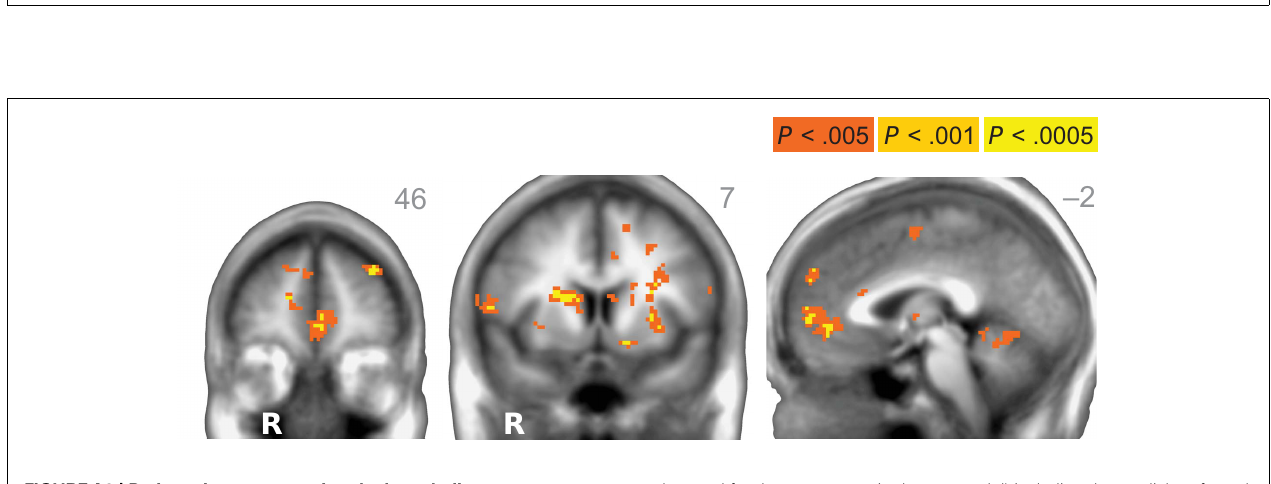
FIGUREA2 | Brain regions representing the hyperbolic discounted value of the sum of the two options. Best fitting values of k for each subject were used to create a regressor of interest for these neuroimaging analyses. Across subjects, activation in a network of mesolimbic regions (similar to what was